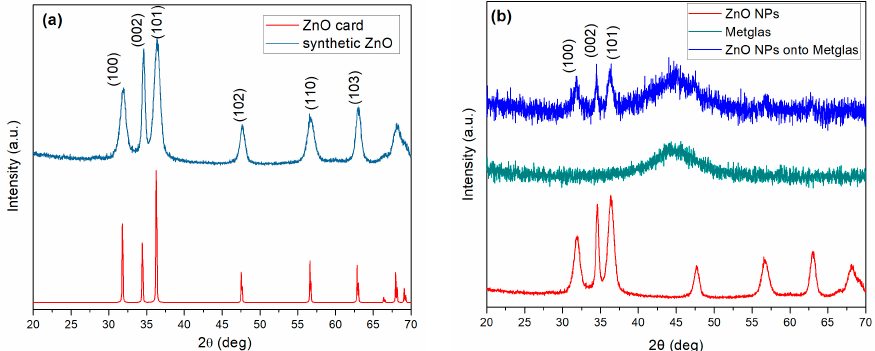
Figure 3. XRD patterns: ( a ) Synthetic ZnO nanoparticles and the standard ZnO wurtzite structure; and ( b ) synthetic ZnO nanoparticles (NPs), a clean strip of Metglas and the ZnO coated Metglas strip.